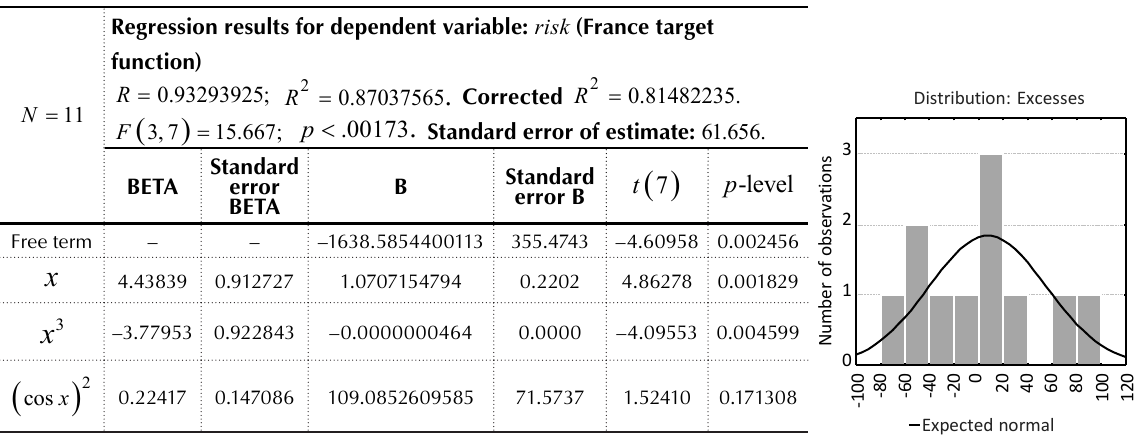
Table 5a. The results of regression for standard deviation of the size of the The Fonds degarantiedes dépôts et de résolution (FGDR) (France) ( ) y from its volume ( ) x